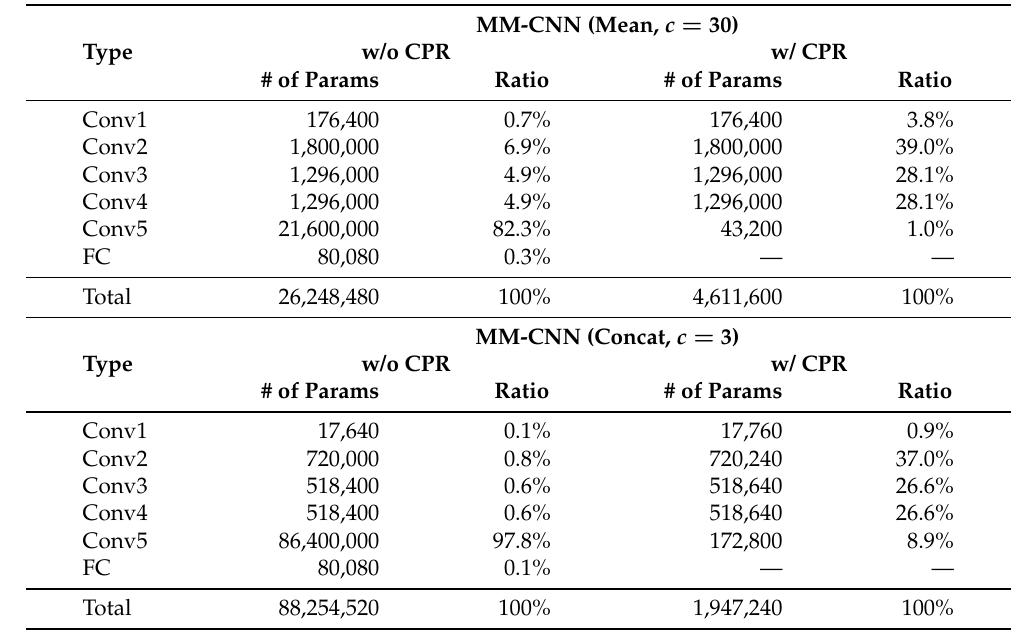
Figure 6. Configuration of CNN classifiers for two-class classification: ( a ) VGG-16 [19], ( b ) MM-CNN, and ( c ) MM-CNN with CPR. Table 4. Effect of reducing the number of weight parameters by CPR, where “Ratio” indicates the ratio of the number of weight parameters in each conv block to the total number of weight parameters in the